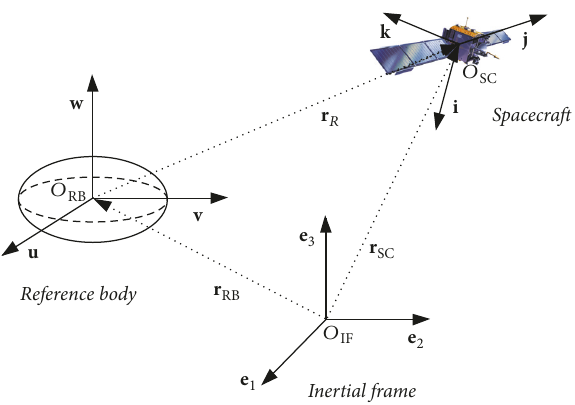
Figure 1: The spacecraft moving in proximity of the reference